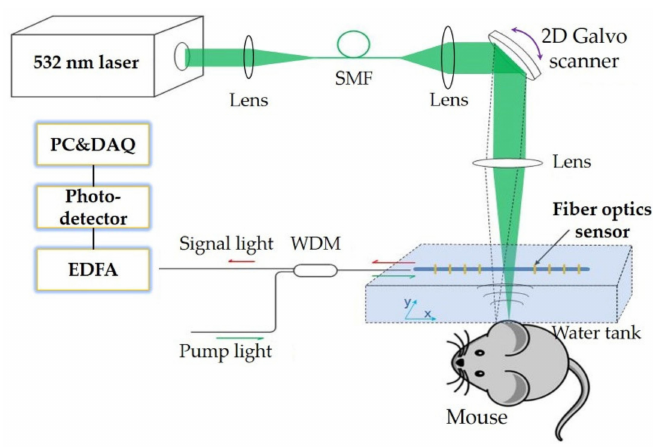
Figure 10. The optical resolution photoacoustic microscopy (OR-PAM) experimental setup, based on the fiber laser sensor. SMF: single mode fiber; WDM: wavelength-division multiplexer; EDFA: erbium-doped fiber amplifier; DAQ: data acquisition. Figure adapted with permission from Ref. [44].